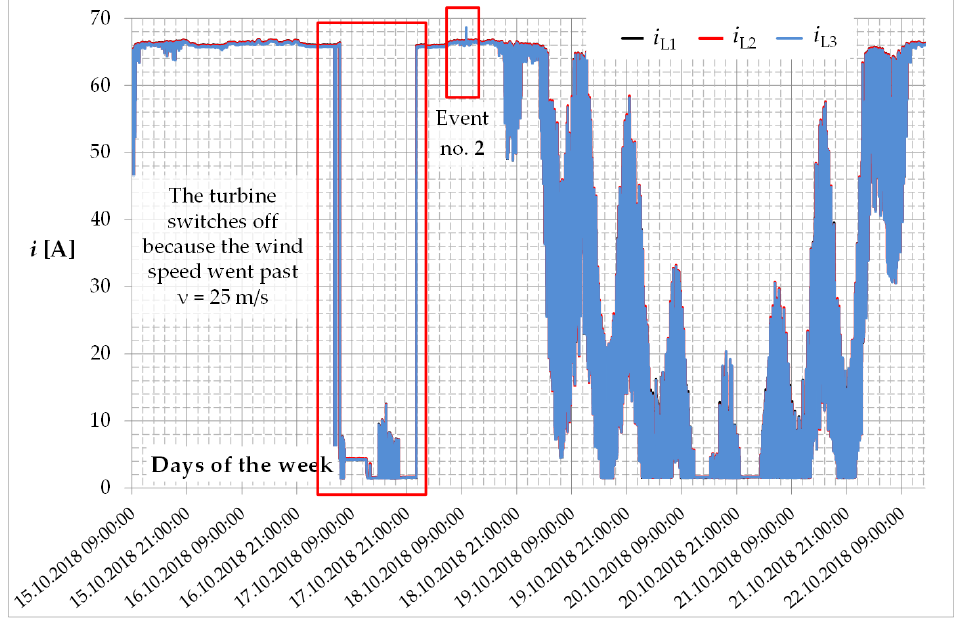
Figure 21. Waveforms of e ff ective currents in PCC during the experiment.